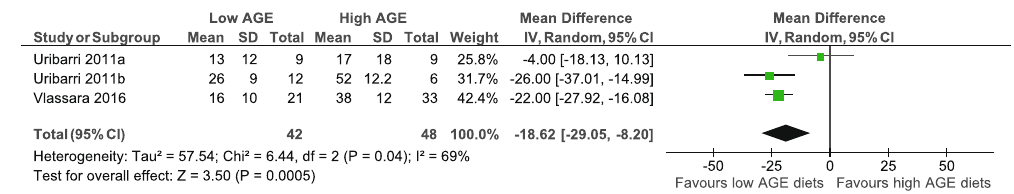
Figure 4. Meta-analysis of low AGE and high AGE diets for leptin (ng/ml): forest plot shows the effect of low AGE and high AGE diets on leptin.